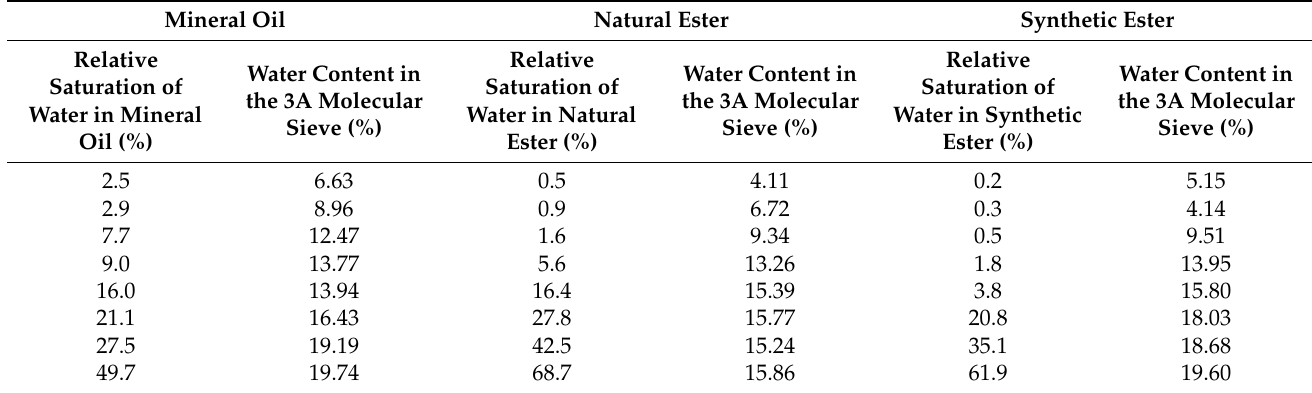
Table 1. Water content in the 3A molecular sieve for various values of relative saturation of water in mineral oil, synthetic ester, and natural ester, T = 35 ◦